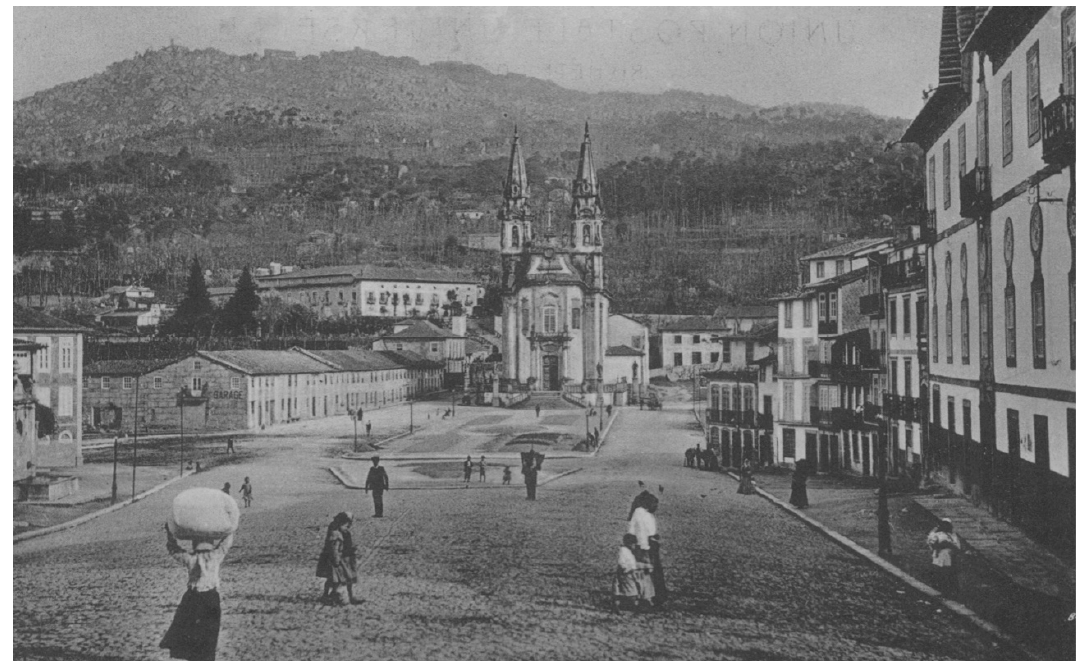
Figure 8. View of the Church of S. Gualter in Largo da República do Brasil, known locally as Campo da Feira, with the Serra de Santa Catarina (Penha) backdrop, at the beginning of the 20th century. As can be seen, a highly significant part of the hill is devoid of vegetation, with the chaos of blocks being evident (image obtained from a postcard from the private collection of the author).